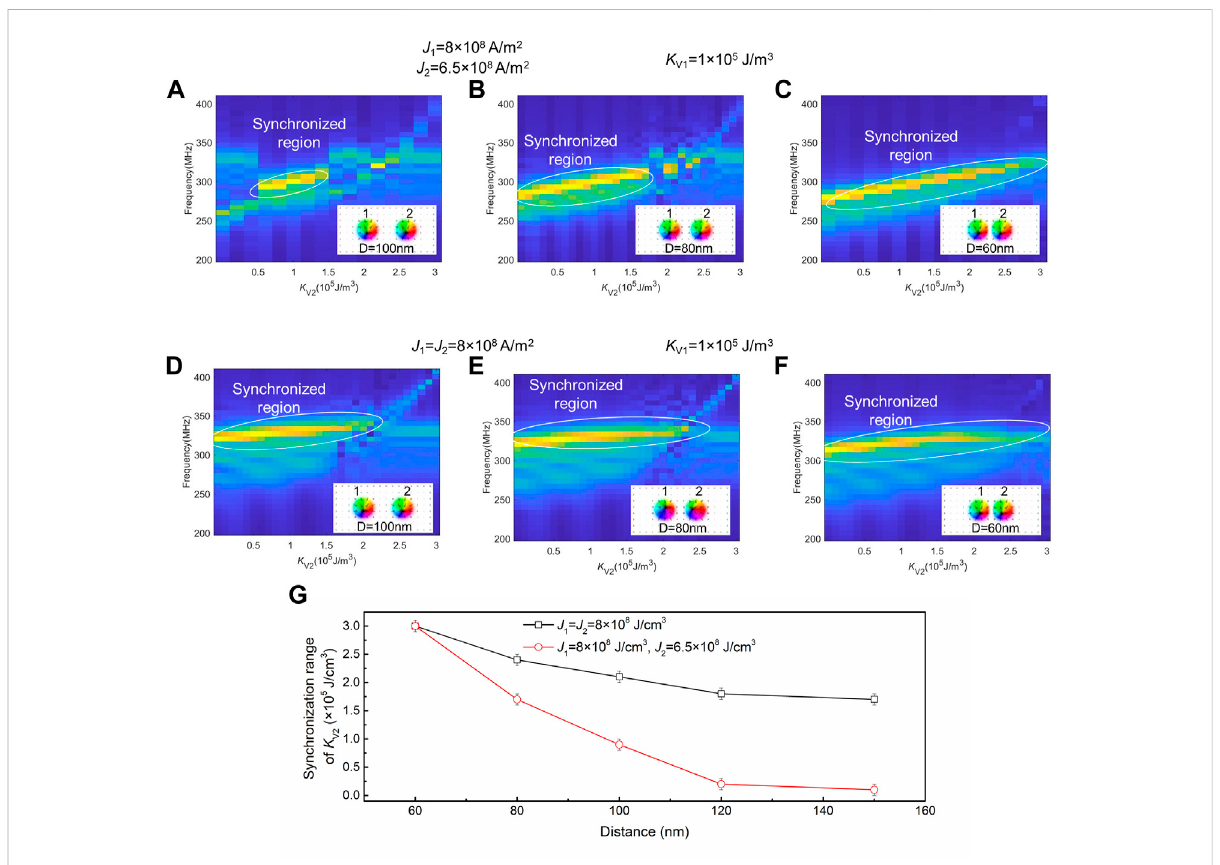
FIGURE 4 (A – C) In fl uenceofoscillatordistanceonthesynchronizationfrequencyspectrafortwooscillatorswithvaryinganisotropy( K V )whenthecurrent density ( J ) for the two oscillators are nonequal ( J 1 = 8 × 10 8 A/m 2 and J 2 = 6.5 × 10 8 A/m 2 ): (A) D = 100 nm (B) D = 80 nm and (C) D = 60 nm. The anisotropyconstantofthevortexregionforoscillator1( K V1 )is fi xedat1×10 5 J/m 3 whilethatofoscillator2( K V2 )isvaried. (D – F) In fl uenceofoscillator distance on the synchronization frequency spectra for two oscillators with varying anisotropy ( K V ) when the current density (J) for both oscillators are equal ( J 1 = J 2 = 8 × 10 8 A/m 2 ): (A) D = 100 nm (B) D = 80 nm and (C) D = 60 nm. The anisotropy constant of the vortex region for oscillator 1 ( K V1 ) is fi xed at 1 × 10 5 J/m 3 while that of oscillator 2 ( K V2 ) is varied. (G) The change of synchronization range with varying the distance of the two oscillators. The error bar is taken as the interval of the variation of the anisotropy constant in the